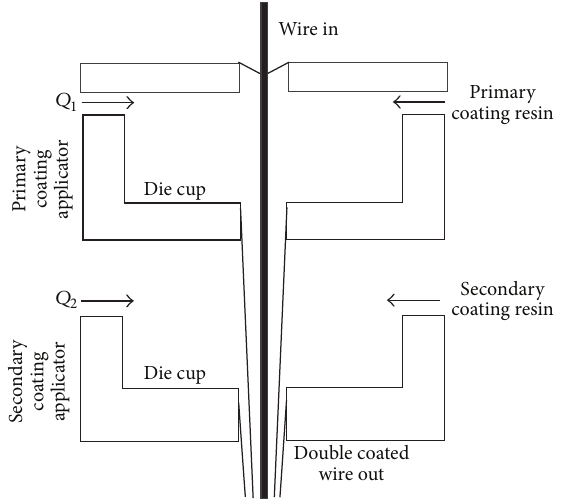
Figure 1: Manufacturing process of